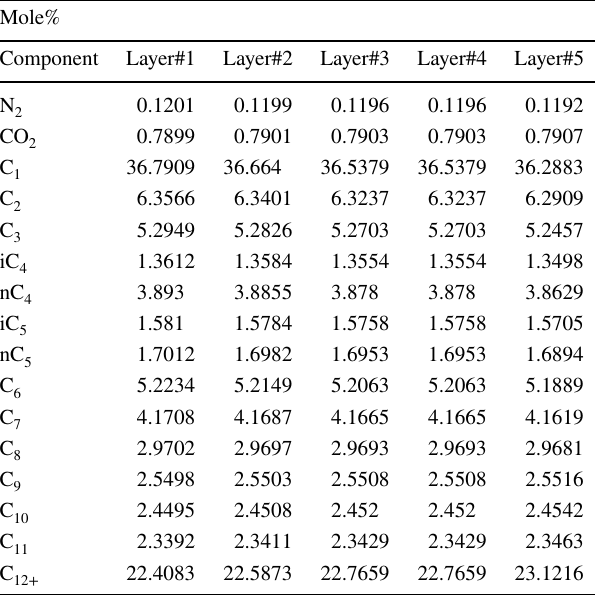
Table 2 Reservoir fluid composition in different layers of the reser- voir